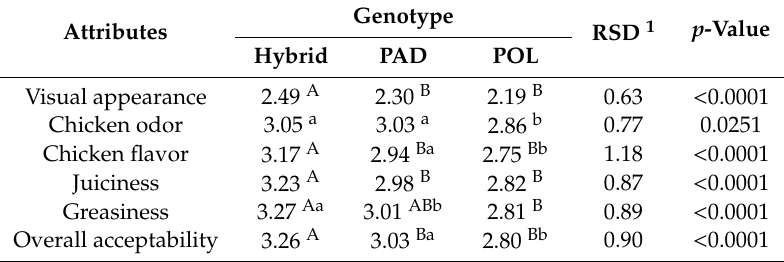
Table 6. Consumer preference analysis of leg meat according to genotype (Hybrid, PAD, and POL).